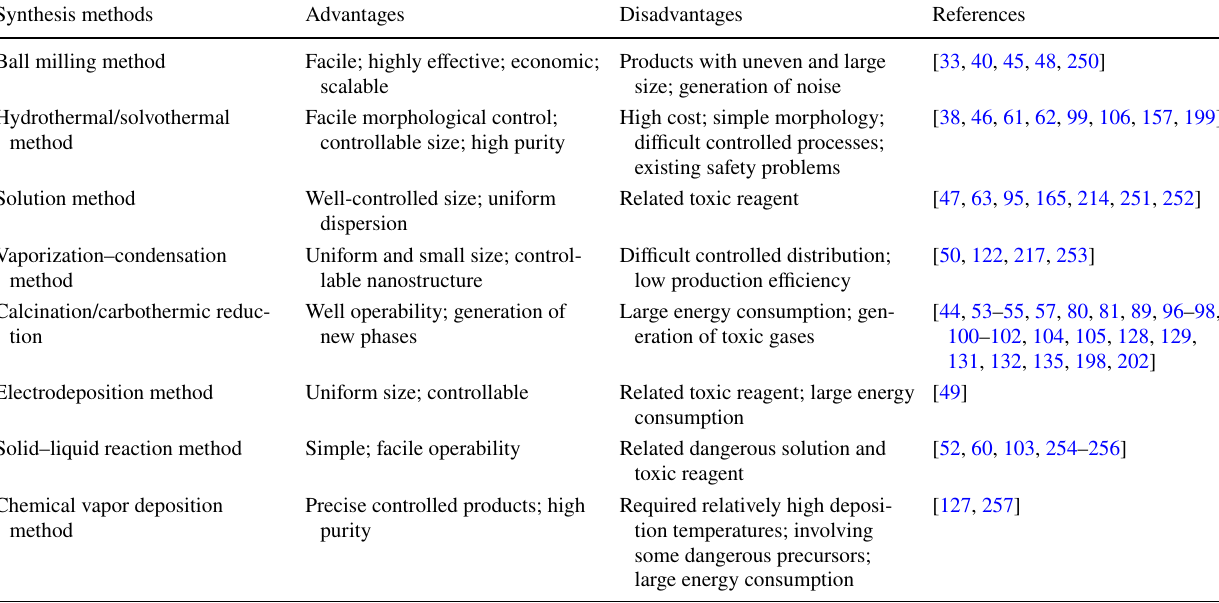
Table 6 Summary of advantages and disadvantage of various synthesis methods for multi-dimensional structures Synthesis